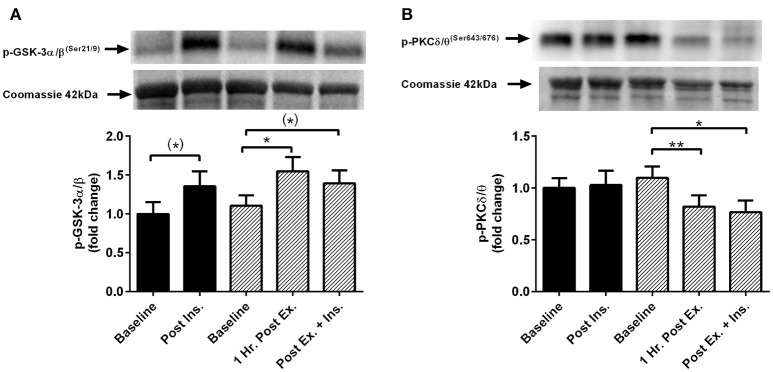
Exercise, insulin stimulation, and skeletal muscle glycogen synthase kinase and protein kinase C signaling. Phosphorylation relative to total protein content in skeletal muscle 1 h after exercise (prior to insulin stimulation), and pre and post insulin stimulation at rest and 3 h after exercise (n = 11). (A) GSK-3α/β(Ser21/9); (B) PKC δ/θ(Ser643/676). *p < 0.05 and **p < 0.01 are significantly different. Black bars = rest trial. Diagonal line bars = exercise trial. Ex. = High-intensity interval exercise. Ins. = insulin stimulation via the hyperinsulinaemic-euglycaemic clamp.